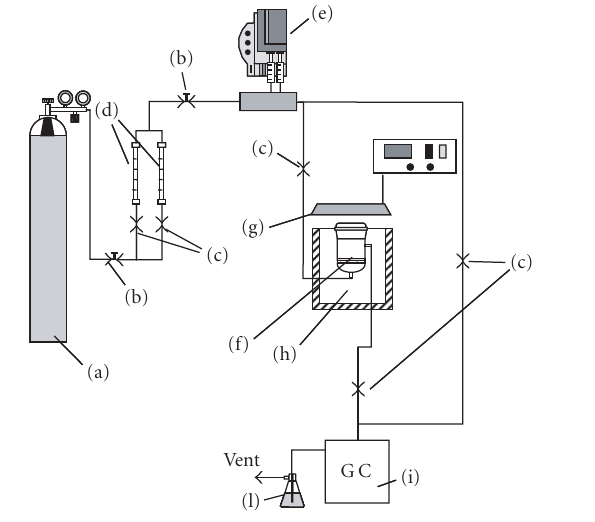
Figure 1: Experimental setup used for toluene photocatalytic degradation in gas-solid regime: (a) air cylinder; (b) control valves; (c) switch valves; (d) rotameters; (e) infusion pump; (f) photo- reactor; (g) irradiation system; (h) oven; (i) gas chromatograph; (j) CO 2 trap.